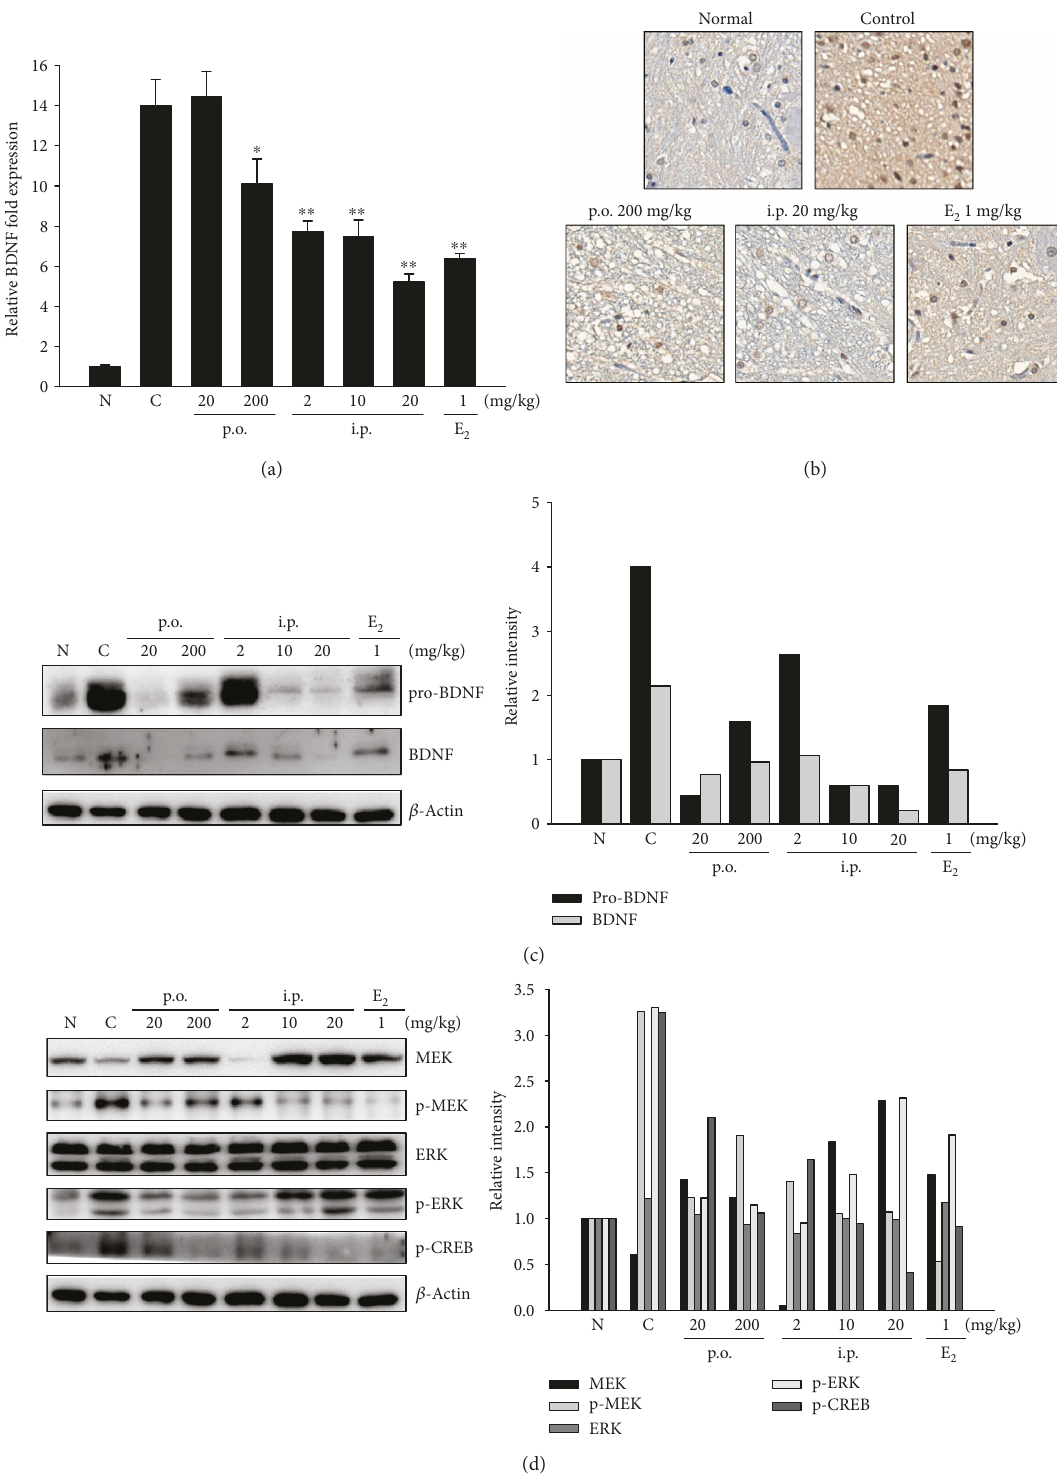
Figure 6: E ff ects of SHINBARO on the expression of neurotrophic factors in the LSS rat model. (a) The mRNA expression of BDNF in spinal cord tissues was determined by real-time RT-PCR. Total RNA was isolated and further analyzed by real-time RT-PCR. The results were normalized using β -actin as an internal control. The data are expressed as the mean ± SD ( n = 4 ). (b) Immunohistochemical analysis of BDNF in the spinal cord. (c) Expression of pro-BDNF and BDNF in spinal cord tissues was investigated by western blot analysis. β -Actin was used as an internal control. (c) Immunostaining analysis of BDNF-positive cells in the spinal cord. (d) Expression of MEK, p-MEK, ERK, p-ERK, and p-CREB in spinal cord tissues was investigated by western blot analysis. β -Actin was used as an internal control. Relative intensity of indicated proteins was semiquanti fi ed using the NIH ImageJ